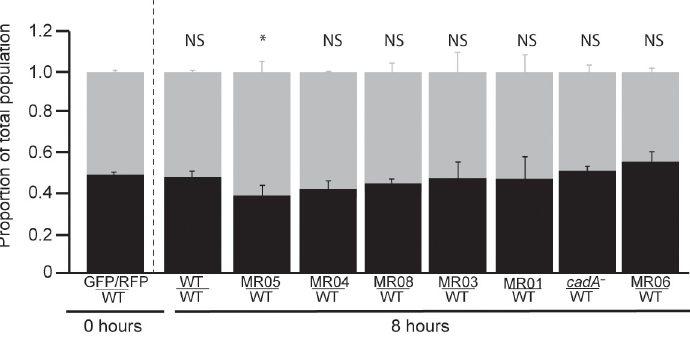
Fig 4. Cheating ability of mutants during growth. We incubated differentially labelled (RFP or GFP) mutant cells in 1:1 mixes with unlabeled wild-type amoebae at 5x10 4 cells/mL in submerged cultures with K . pneumoniae . We counted the number of labeled and unlabeled cells by fluorescence microscopy immediately after plating (0 hours) and after 8 hours, and calculated the ratios between the labeled and unlabeled cells (y-axis). The bar graphs show the proportion of each strain as the mean of 3 independent replicates; error bars represent the standard error of the mean. Strain names are indicated on the x-axis (fluorescently-labelled cells on top, grey bars; unlabeled wild type on the bottom, black bars). MR01, MR03, MR04, MR05, and wild-type cells were tagged with GFP; MR08, cadA – , and MR06 were labeled with RFP. We tested each instance for difference from the 0-hours sample by a Student t-test and indicated the results above the bars: NS, not significant; � P �